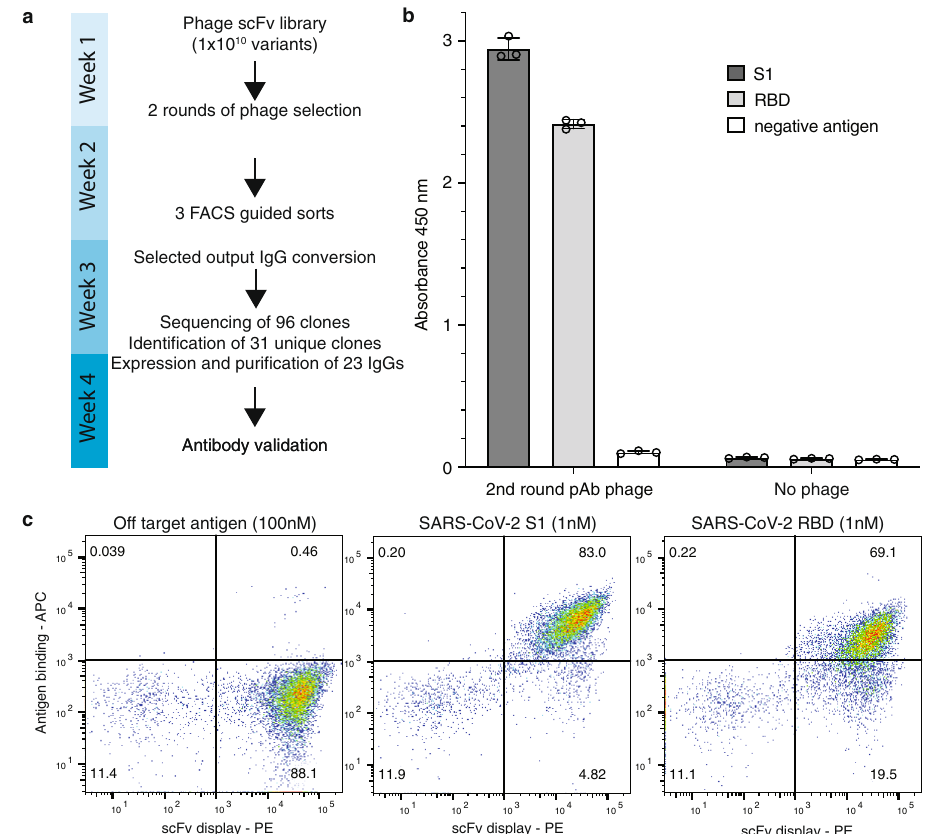
Fig. 1 Antibody selection. a Timeline of the entire pipeline: from phage selection to the validation of the selected antibodies. b Binding signal of the polyclonal phage population obtained after two round of phage display selections against SARS-CoV-2 S1 and SARS-CoV-2 RBD. Data represent the average of three polyclonal phage preparations ( n = 3) + / − SD. Source data are provided as a Source Data File. c Analysis of binding signals by fl ow cytometry of the fi nal antibody population obtained after yeast display against SARS-CoV-2 S1 and SARS-CoV-2